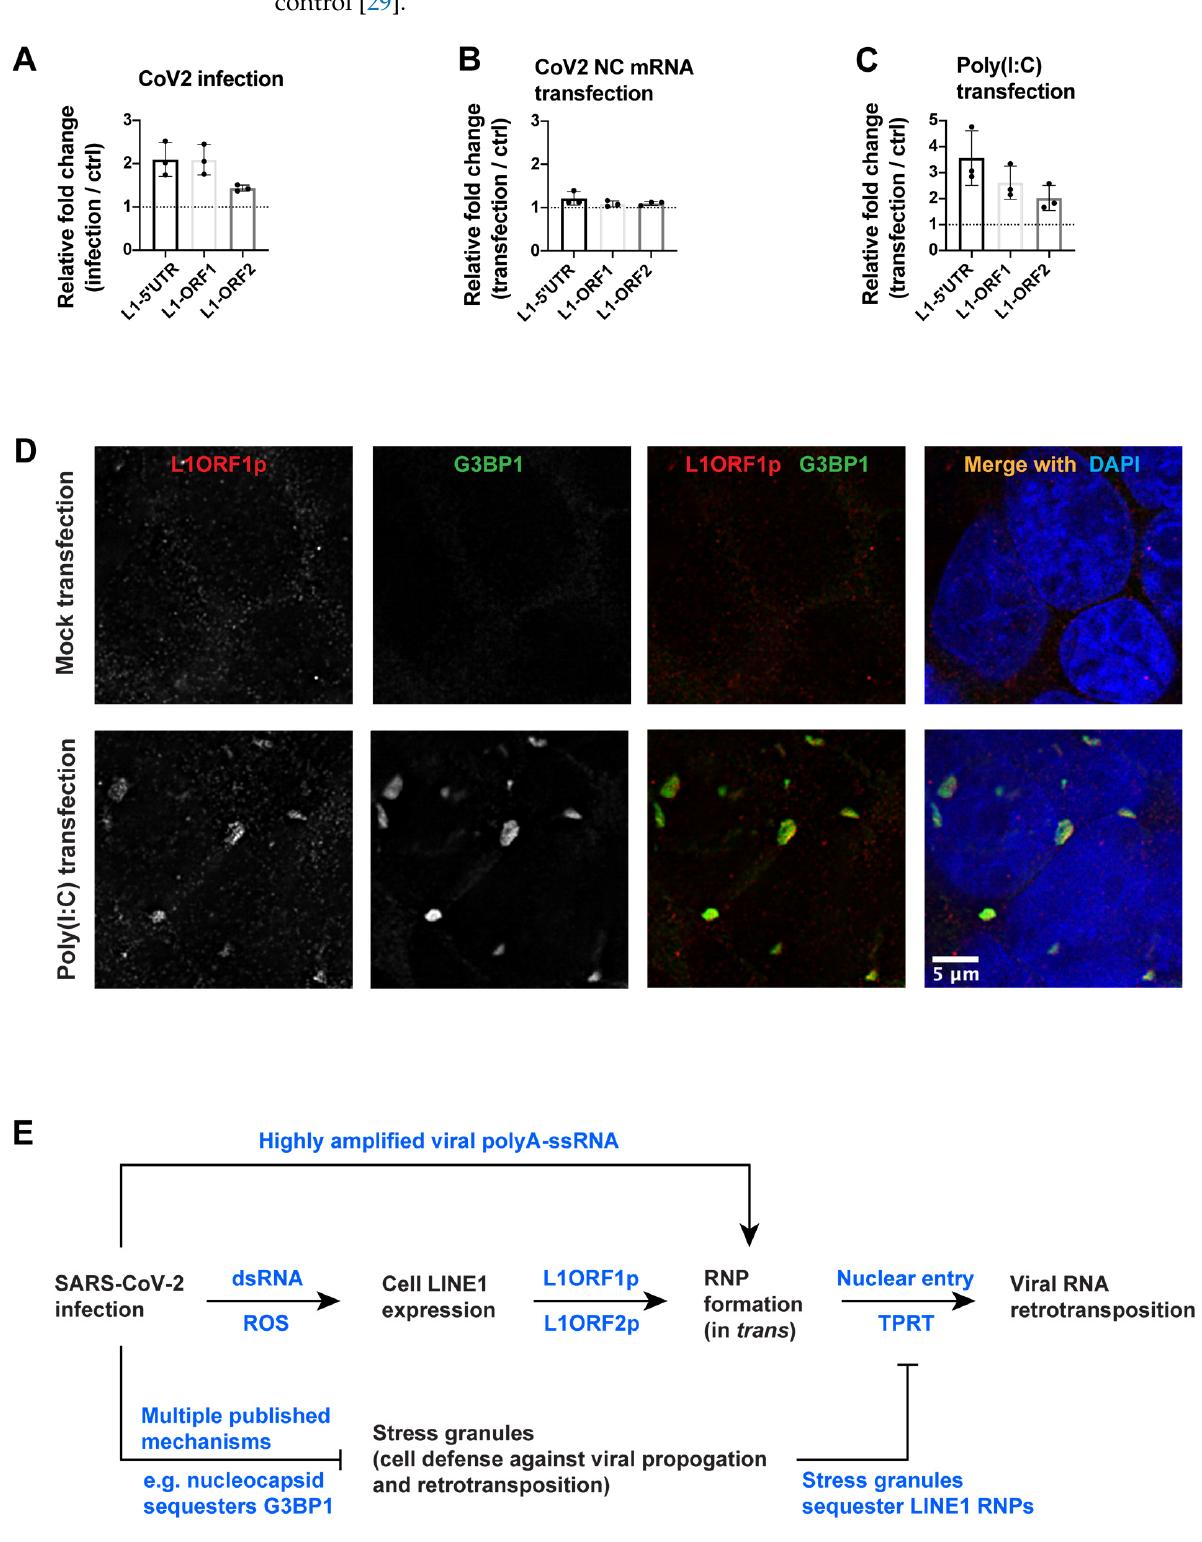
Figure 3. SARS-CoV-2 infection and related cellular stress, but not SARS-CoV-2 nucleocapsid mRNA transfection, can induce endogenous LINE1 expression. ( A – C ) LINE1 mRNA level fold-change detected by RT-qPCR in ( A ) Calu3 cells infected by SARS-CoV-2 for 2 days, ( B ) 293T cells transfected by nucleocapsid (NC) mRNA (~1.8 kb with polyA), with 0.5 μ g RNA per 1mL cell culture medium for 24 h, or ( C ) 293T cells transfected by a synthetic analog of double-stranded RNA, Poly(I:C) (HMW, 1.5–8 kb), with 2 μ g per 1mL cell culture medium for 24 h. RT-qPCR was performed using L1HS/L1PA(2-6) specific primers targeting LINE1 5 ′ -UTR or ORF1, and L1HS specific primers targeting LINE1 ORF2, on purified cellular poly-A RNA (method and primer sequences following the protocols in a previous publication [2] , see Materials and Methods). n = 3 independent experi- ments (biological replicates). Data are the mean ± standard deviation (SD). One-tailed t-test for LINE1 mRNA upregulation in infected/transfected cells: ( A ) p = 0.098 (L1-5 ′ UTR), p = 0.021 (L1- ORF1), p = 0.303 (L1-ORF2); ( B ) p = 0.194 (L1-5 ′ UTR), p = 0.379 (L1-ORF1), p = 0.315 (L1-ORF2); ( C ) p = 0.143 (L1-5 ′ UTR), p = 0.121 (L1-ORF1), p = 0.020 (L1-ORF2). ( D ) Immunofluorescent staining of L1ORF1p (red) and G3BP1 (green) and merged channels with DAPI staining (blue) in mock-trans- fected or Poly(I:C) (HMW, 1.5–8 kb) transfected 293T cells. Cells were transfected by Poly(I:C) (HMW, 1.5–8 kb), with 2 μ g per 1mL cell culture medium for 24 h. ( E ) A proposed model for mech- anisms involved in LINE1-mediated viral RNA retrotransposition in infected cells. In this model,